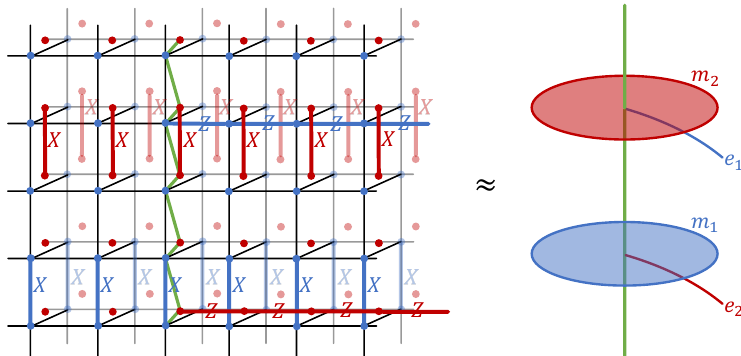
Figure 14: The membrane operators that commute with all terms except near bound- aries. When the m ( m ) membrane operator intersects with the twist string, the 1 2 string operator of charge e ( e ) comes out from the intersection 2 1